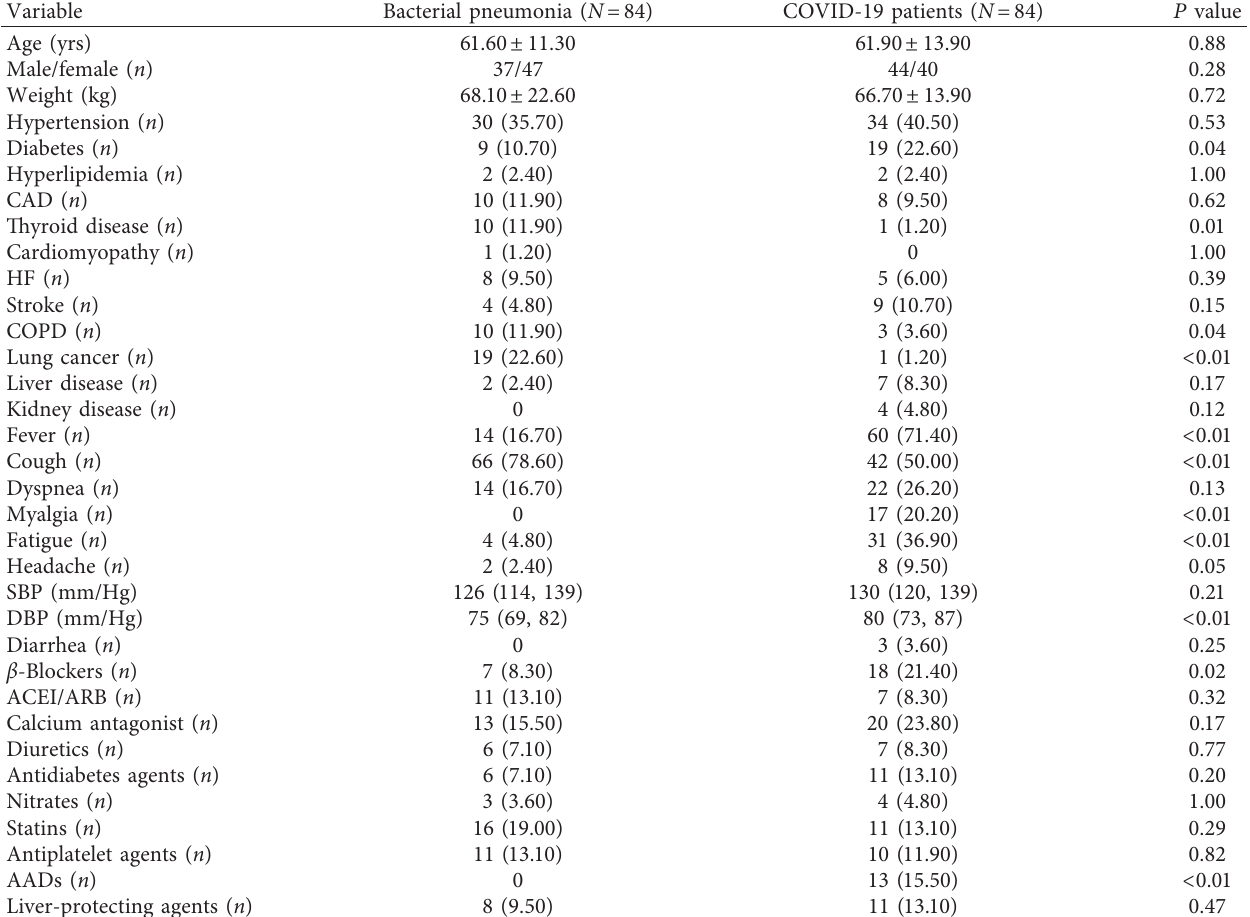
Table 1: Baseline characteristics of patients with bacterial pneumonia and COVID-19 patients.